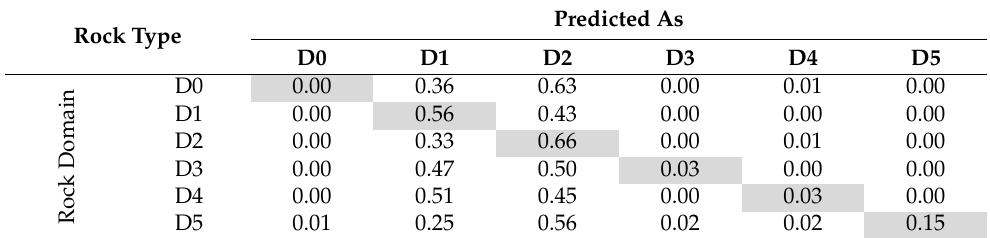
Table 10. Confusion matrix for 2D RF modeling for NW.